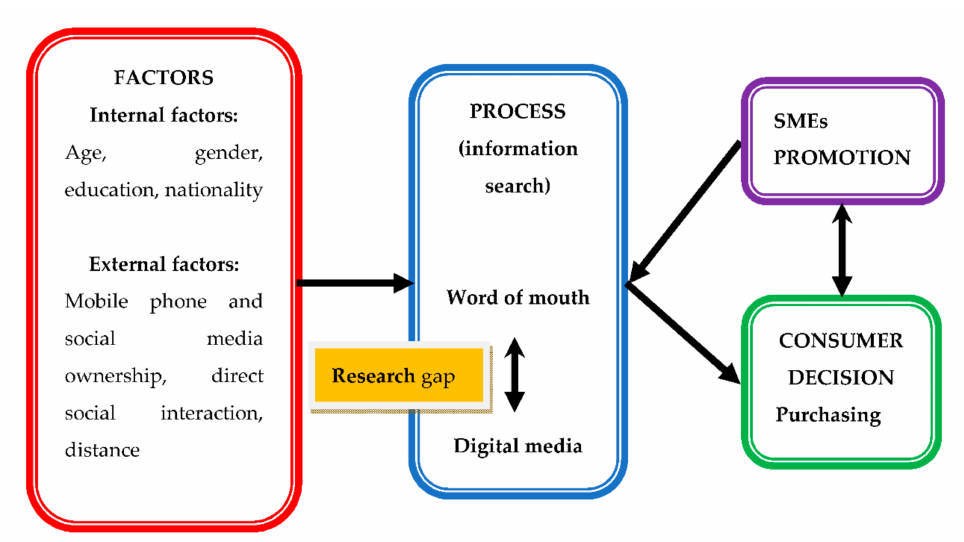
Figure 1. Theoretical framework of this study. SMEs, small and medium